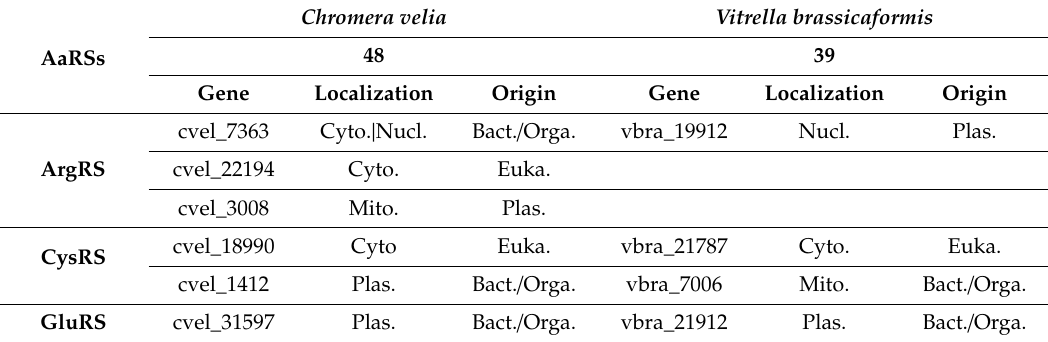
Table 1. Summary of the subcellular localization and origin of the identified Aminoacyl-tRNA synthetases (AaRS) in chromerids ( Chromera velia and Vitrella brassicaformis ). Four letters are used to describe the predicted localization of AaRSs (Cyto. = Cytoplasm; Nucl. = Nucleus; Mito. = Mitochondria; Plas. = Plastid; Endo. = E ndoplasmic reticulum) and their origins (Euka. = Eukaryotic; Mito. = Mitochondrial; Plas. = Plastidal; Bact. / Orga. = Bacterial / Organellar; Uncl. = Unclear), while the number of transcripts is between parenthesis if it was